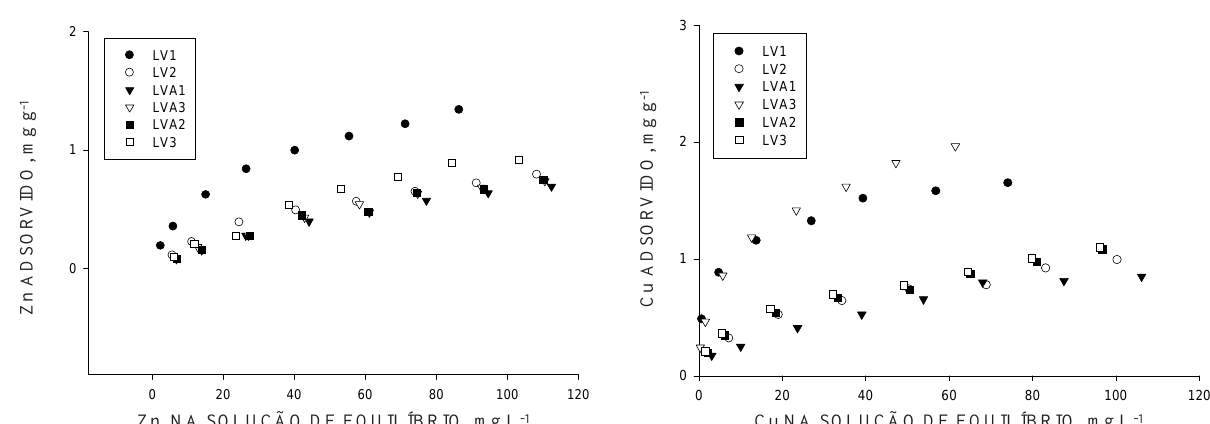
Zn NA SOLUÇÃO DE EQUILÍBRIO, mg L -1 Cu NA SOLUÇÃO DE EQUILÍBRIO, mg L Figura 1. Relação entre os teores de zinco e de cobre adsorvidos na solução de equilíbrio em seis Latossolos.